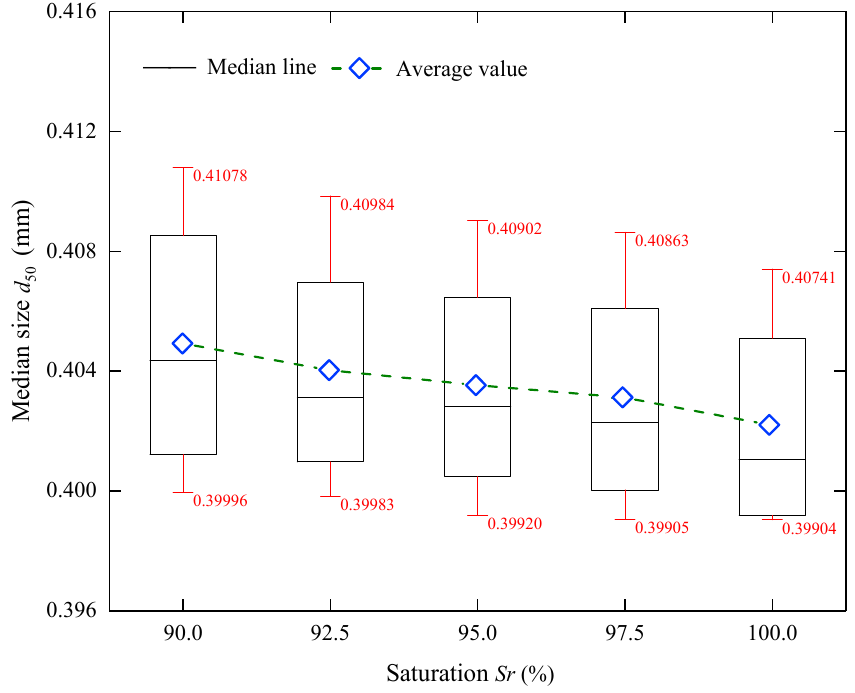
Figure 20. Relationship between median particles size and saturation of coral sand.